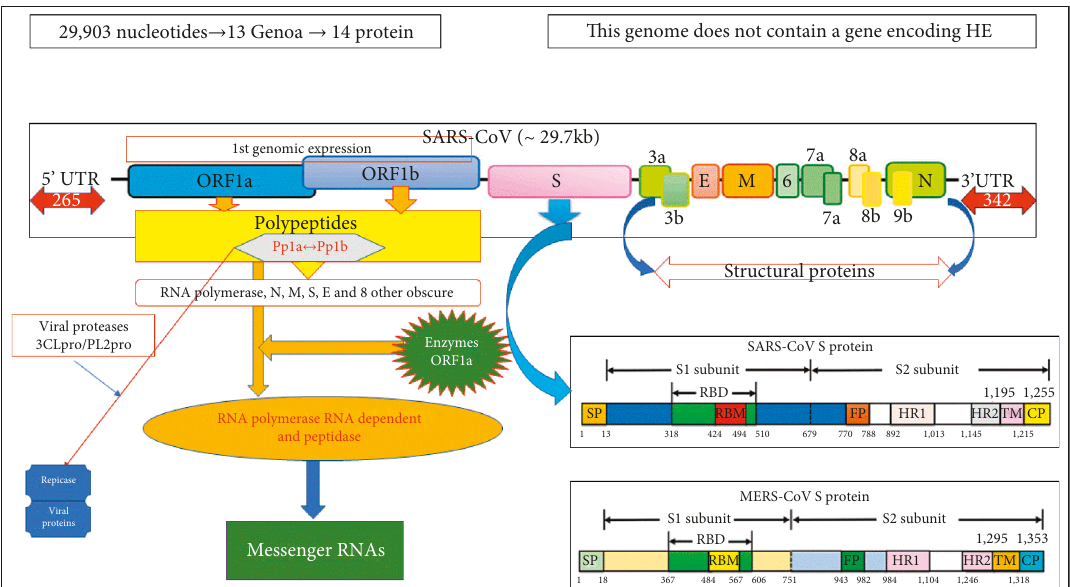
Figure 4: Description of the expressions of reading frames Orf1 to Orf2, protein S, and Orf3a to 9b (Source: https://mdpi.com supplemented by this